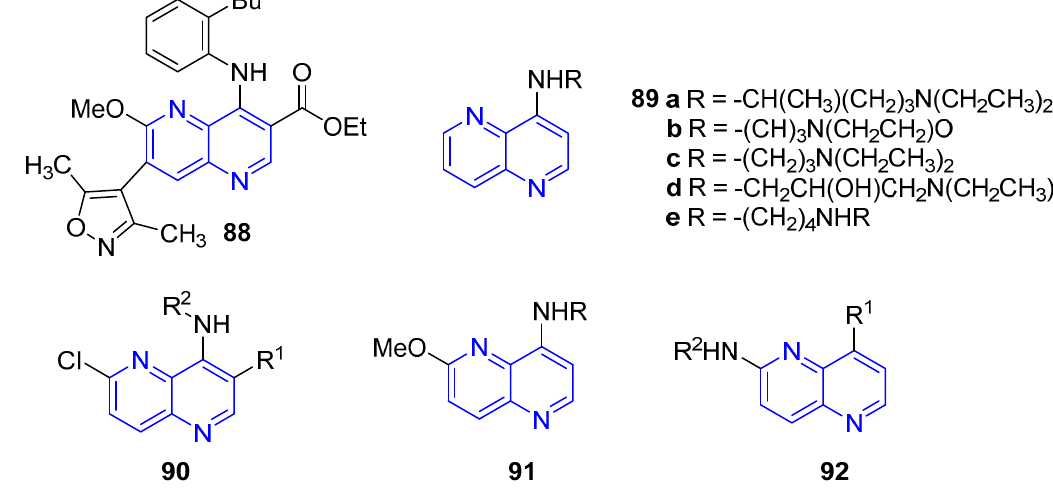
Figure 3. Compounds obtained by amination of halogenated 1,5-naphthyridine derivatives.